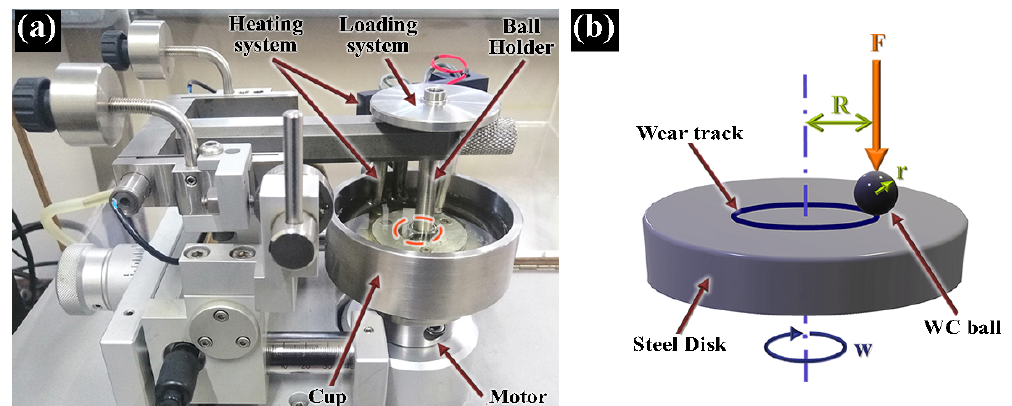
Figure 2. High temperature lubricated friction tests: setup ( a ), and ball-on-disk scheme ( b ). The evolution of the kinetic friction coefficient ( µ k ) was recorded through the tests by the computer of the equipment which also provides the average values. After completing 30,000 cycles, the worn surfaces were analyzed by optical microscopy with Carl Zeiss Axio Imager.A1m microscope from Carl Zeiss, Oberkochen (Baden-Württemberg), Germany. The wear track widths were measured, and the volume loss (V) and wear rate (K) were calculated according to Equations (1) and (2), respectively. In this study, only the wear rate values are reported.